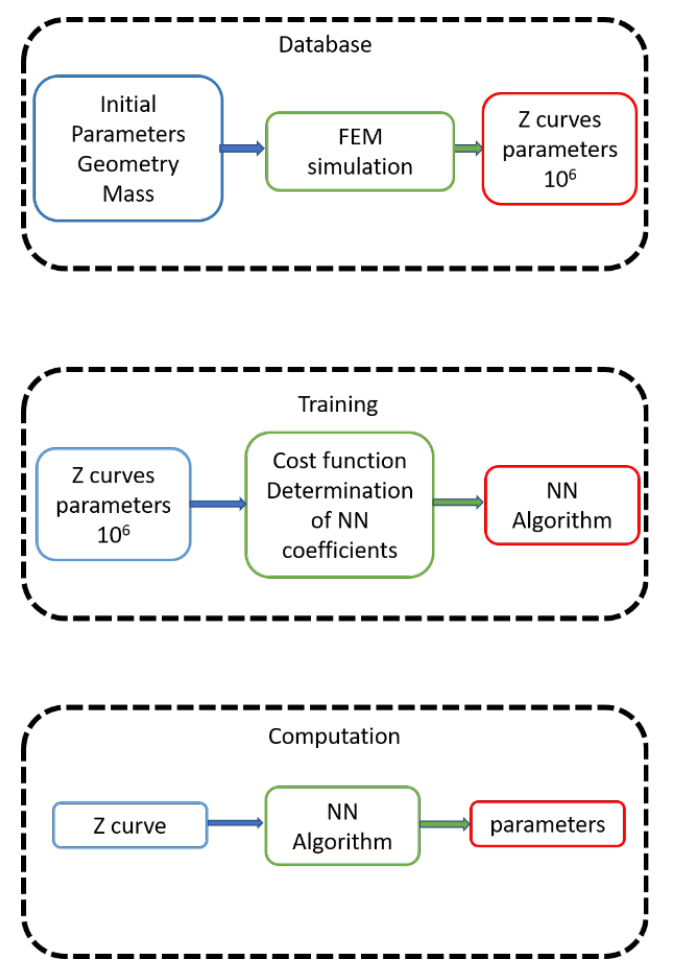
Figure 2. Neural network (NN) approach. Blue indicates the input data, green the calculus and red the results of each phase. Each phase has an input, computation, and a result.